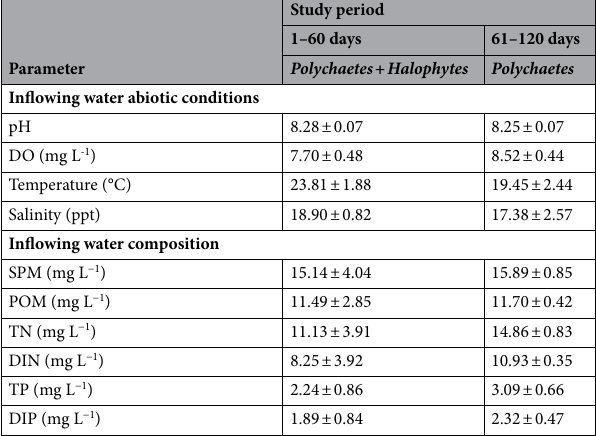
Table 1. Abiotic conditions (pH, oxygen, temperature and salinity) and composition [suspended particulate matter (SPM), particulate organic matter (POM; %LOI in SPM), total nitrogen (TN), total phosphorus (TP), dissolved inorganic nitrogen (DIN) and phosphorus (DIP)] measured in inflowing water. Average values ± SD (n = 5).